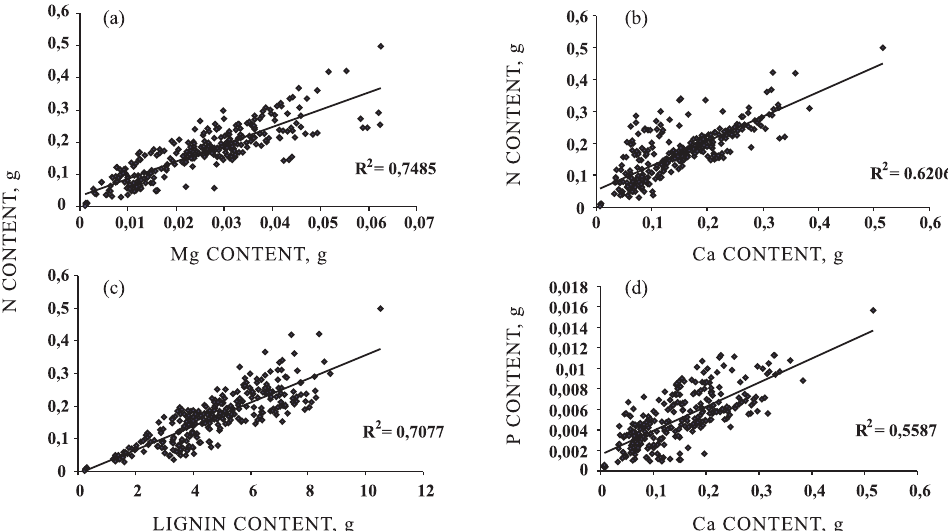
Figure 8. The better correlation of some nutrients and mulch characteristics: N content with Mg content (a), Ca content (b) and lignin content (c), and correlation of phosphorus content and Ca content. The correlation was made during the incubation time of litterbag with different material content.